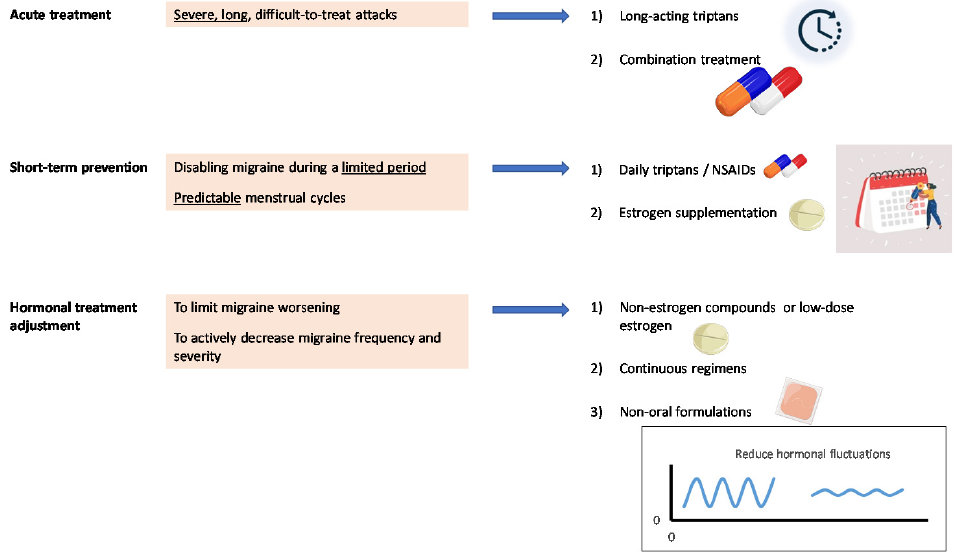
Figure 4. Suggestions for the treatment of menstrual migraine in clinical